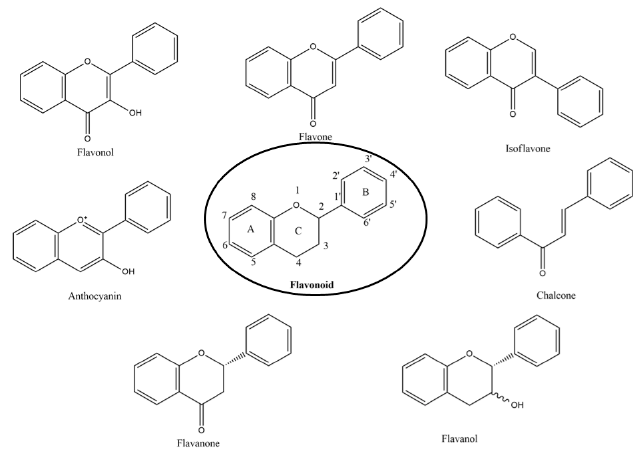
Figure 1. Structure of different groups of flavonoids.